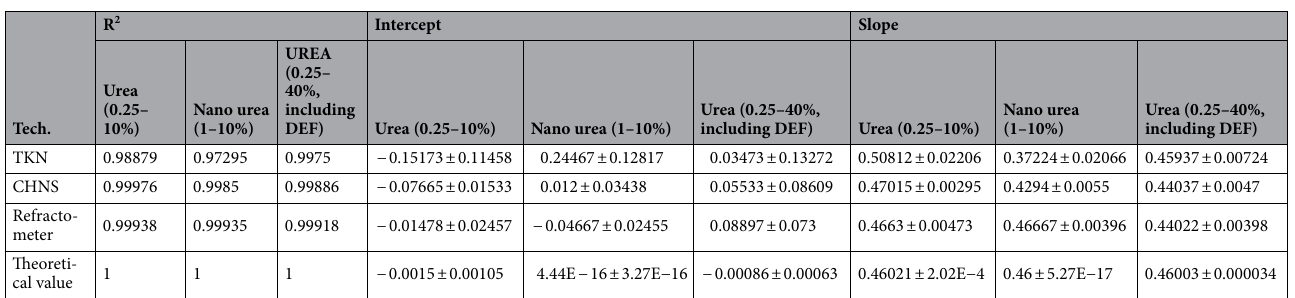
Table 2. Different analysis methods for various concentrations (up to 10%) of urea and nano urea and their R 2 , intercept, and slope values extracted by linear